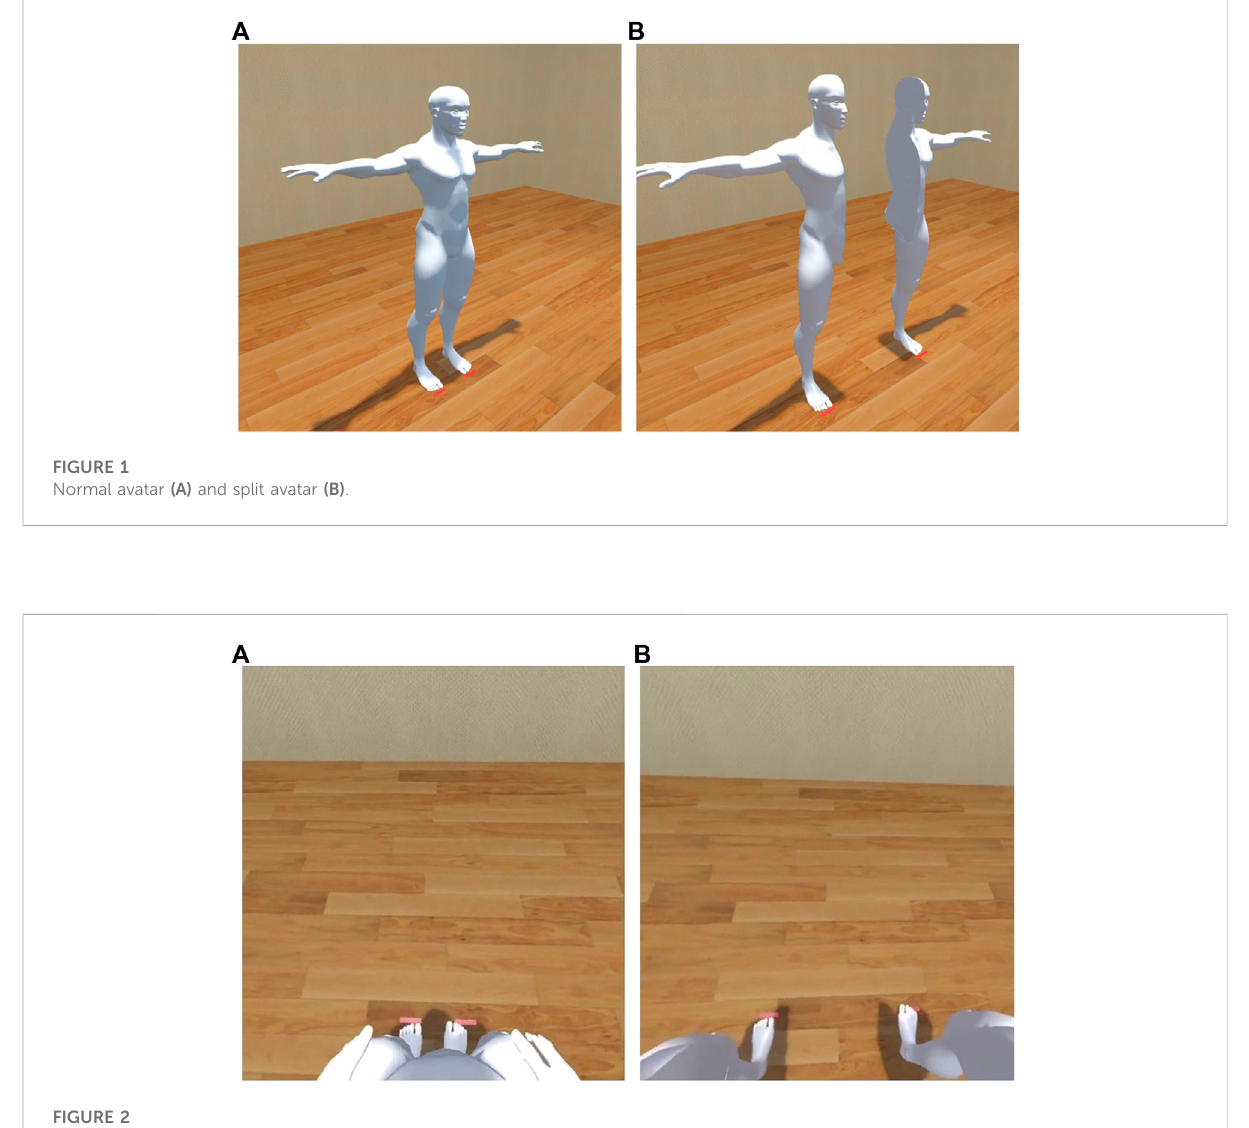
FIGURE 2 Participant ’ s view: normal avatar (A) and split avatar (B) .